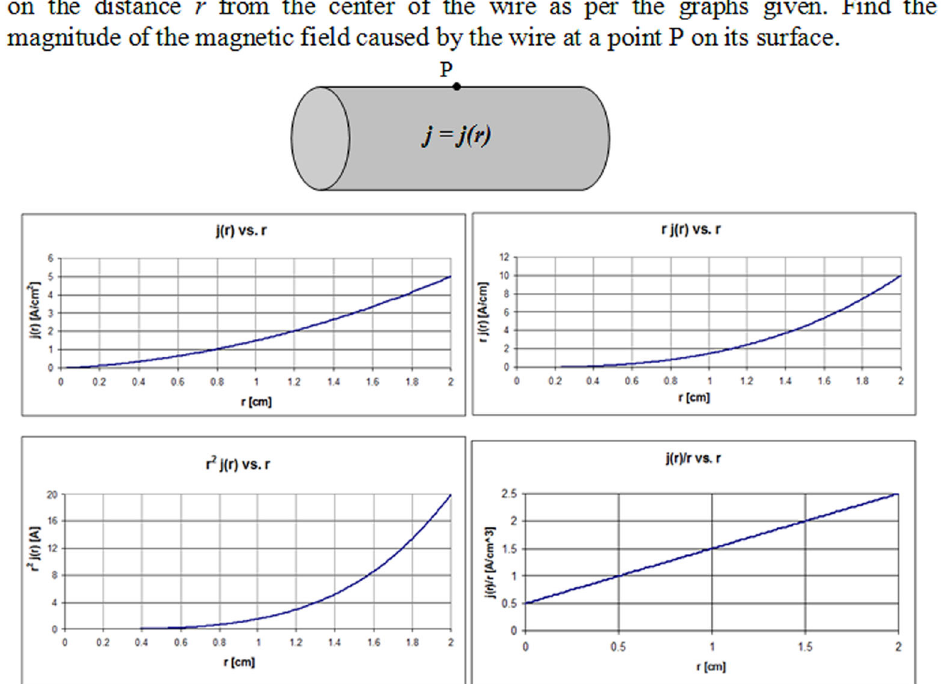
FIG. 6 (color online). The current problem (interview